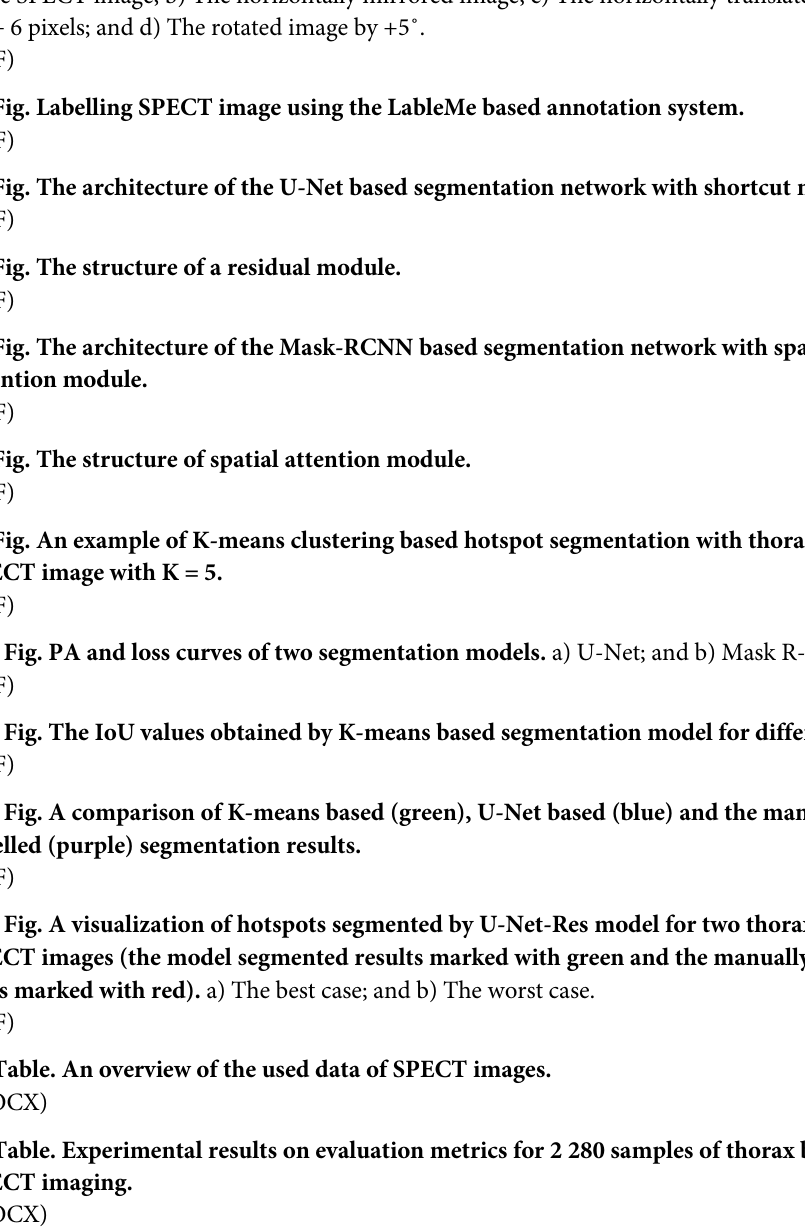
S2 Fig. Curve fitting based technique for identifying thorax area. a) The original curve and its fitted one; and b) The curves of the first and second derivatives. S3 Fig. An example of preprocessing thorax bone SPECT image. a) The original thorax bone SPECT image; b) The horizontally mirrored image; c) The horizontally translated image by + 6 pixels; and d) The rotated image by +5˚. S4 Fig. Labelling SPECT image using the LableMe based annotation system. S5 Fig. The architecture of the U-Net based segmentation network with shortcut module. S6 Fig. The structure of a residual module. S7 Fig. The architecture of the Mask-RCNN based segmentation network with spatial attention module. S8 Fig. The structure of spatial attention module. S9 Fig. An example of K-means clustering based hotspot segmentation with thorax bone SPECT image with K = 5. S10 Fig. PA and loss curves of two segmentation models. a) U-Net; and b) Mask R-CNN. S11 Fig. The IoU values obtained by K-means based segmentation model for different. S12 Fig. A comparison of K-means based (green), U-Net based (blue) and the manually labelled (purple) segmentation results. S13 Fig. A visualization of hotspots segmented by U-Net-Res model for two thorax bone SPECT images (the model segmented results marked with green and the manually labeled ones marked with red). a) The best case; and b) The worst case. S1 Table. An overview of the used data of SPECT images. S2 Table. Experimental results on evaluation metrics for 2 280 samples of thorax bone SPECT